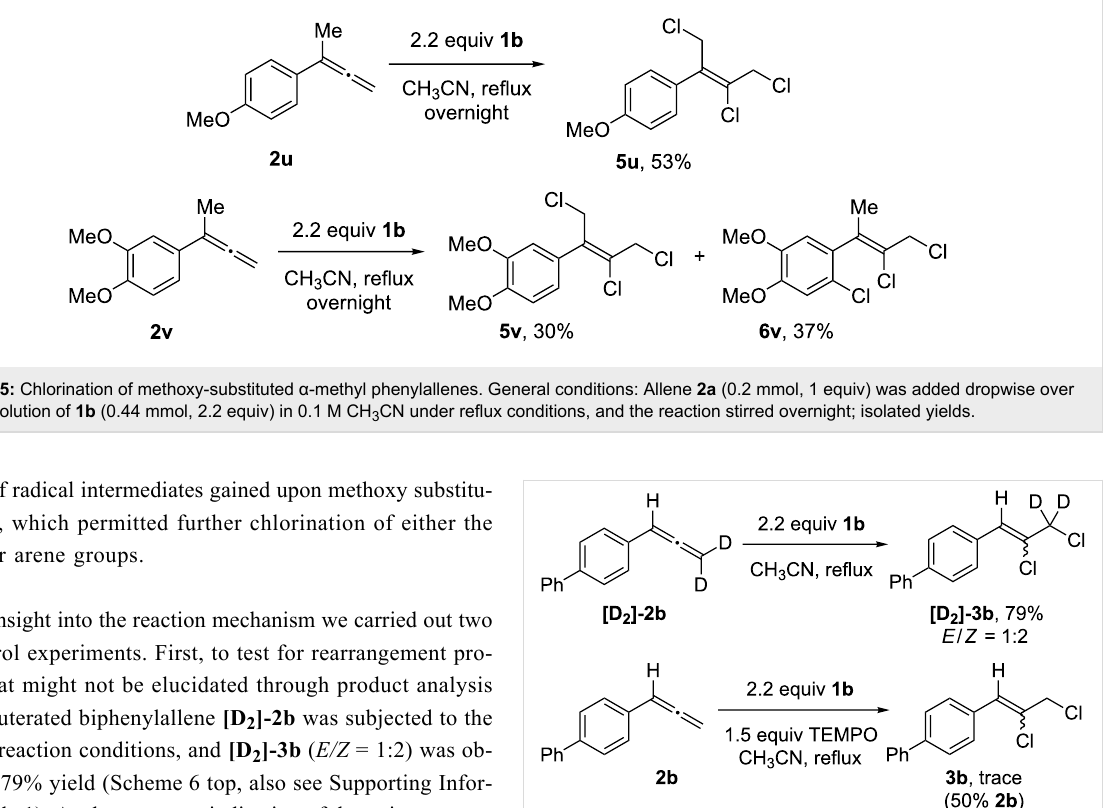
Scheme 6: Control reactions: (a) chlorination of deuterated biphenylal- lene [D 2 ]-2b ; (b) reaction with TEMPO.